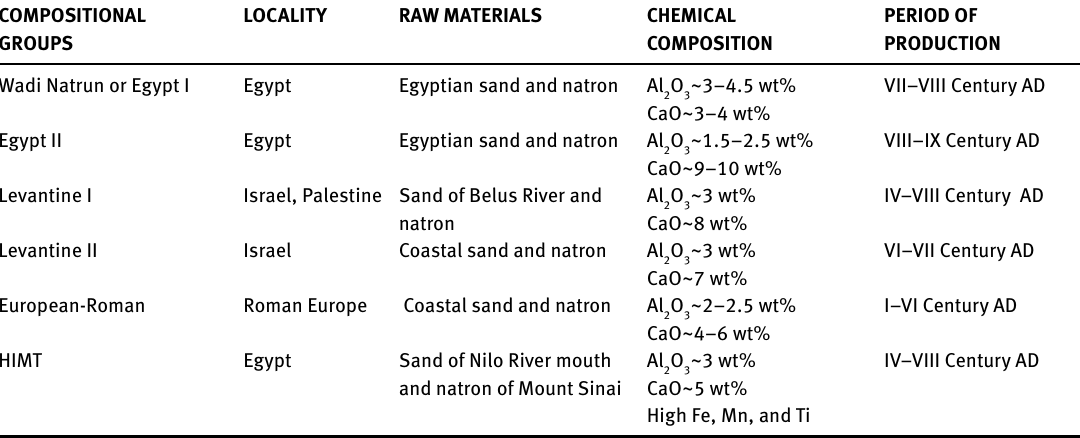
Table 2: Some of the most widespread compositional groups of Roman Glass characterized by the use of natron as flux, produ- ced in the 1 st millennium AD from raw materials extracted in the Near East. Data from literature (Sayre & Smith, 1961; Gratuze & Barrandon, 1990; Mirti, Casoli, & Appollonia, 1993; Freestone, Gorin-Rosen, & Hughes, 2000; Nenna, 2000; Freestone et al., 2008; and references